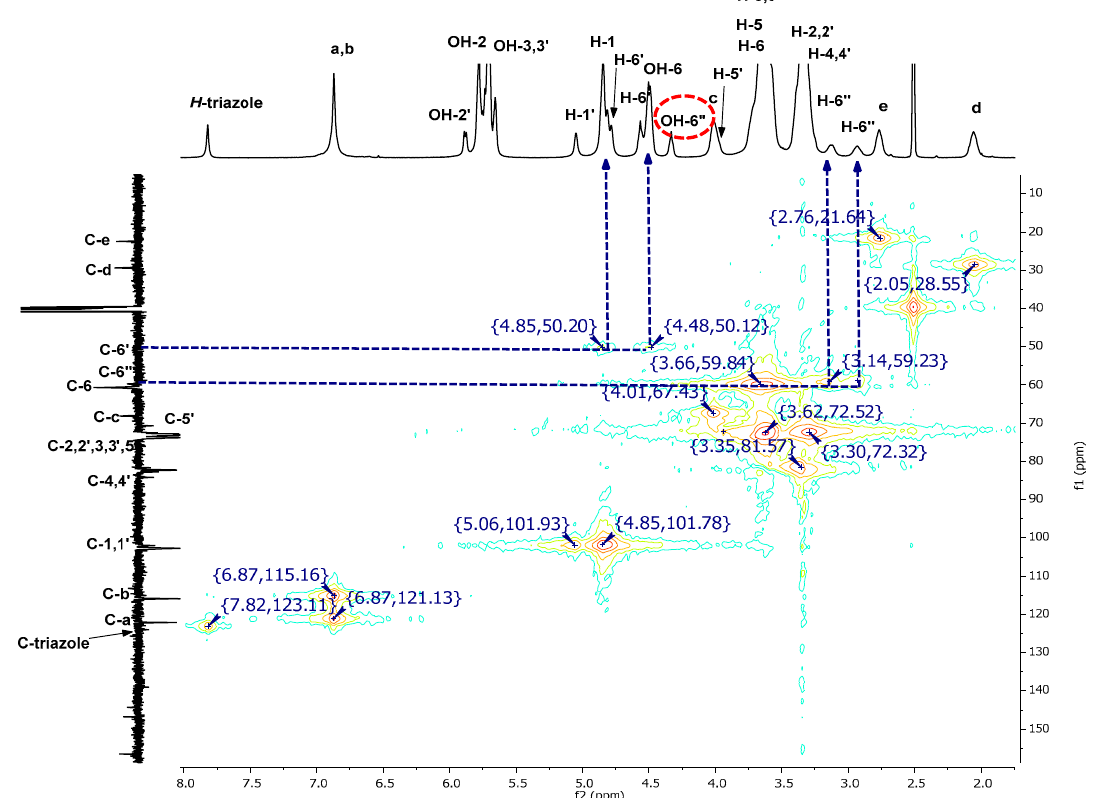
Figure 2. 2D NMR Heteronuclear Multiple-Quantum Correlation (HMQC) spectra of P 3 N 3 -[ O -C 6 H 4 - O -(CH 2 ) 3 - β CD] 6 PDCs in DMSO- d 6 .